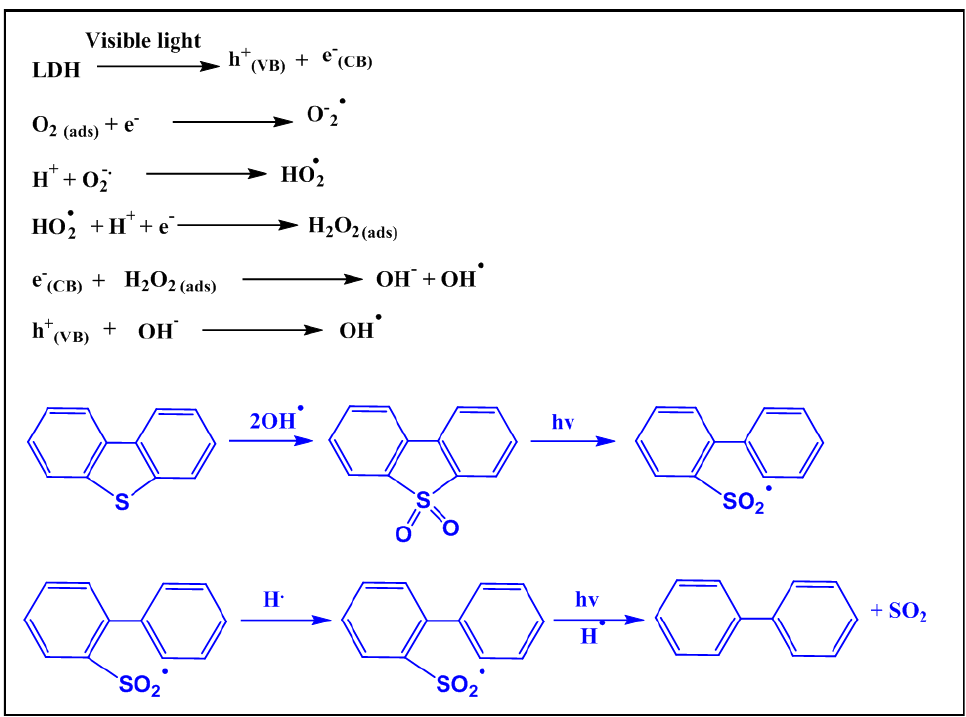
Figure 6. The photo-desulfurization mechanism over the (NiCo 2 -LDH/Fe 3 O 4 )-composite. (Adopted from Masoumi and Hosseini [96], with permission from Elsevier).